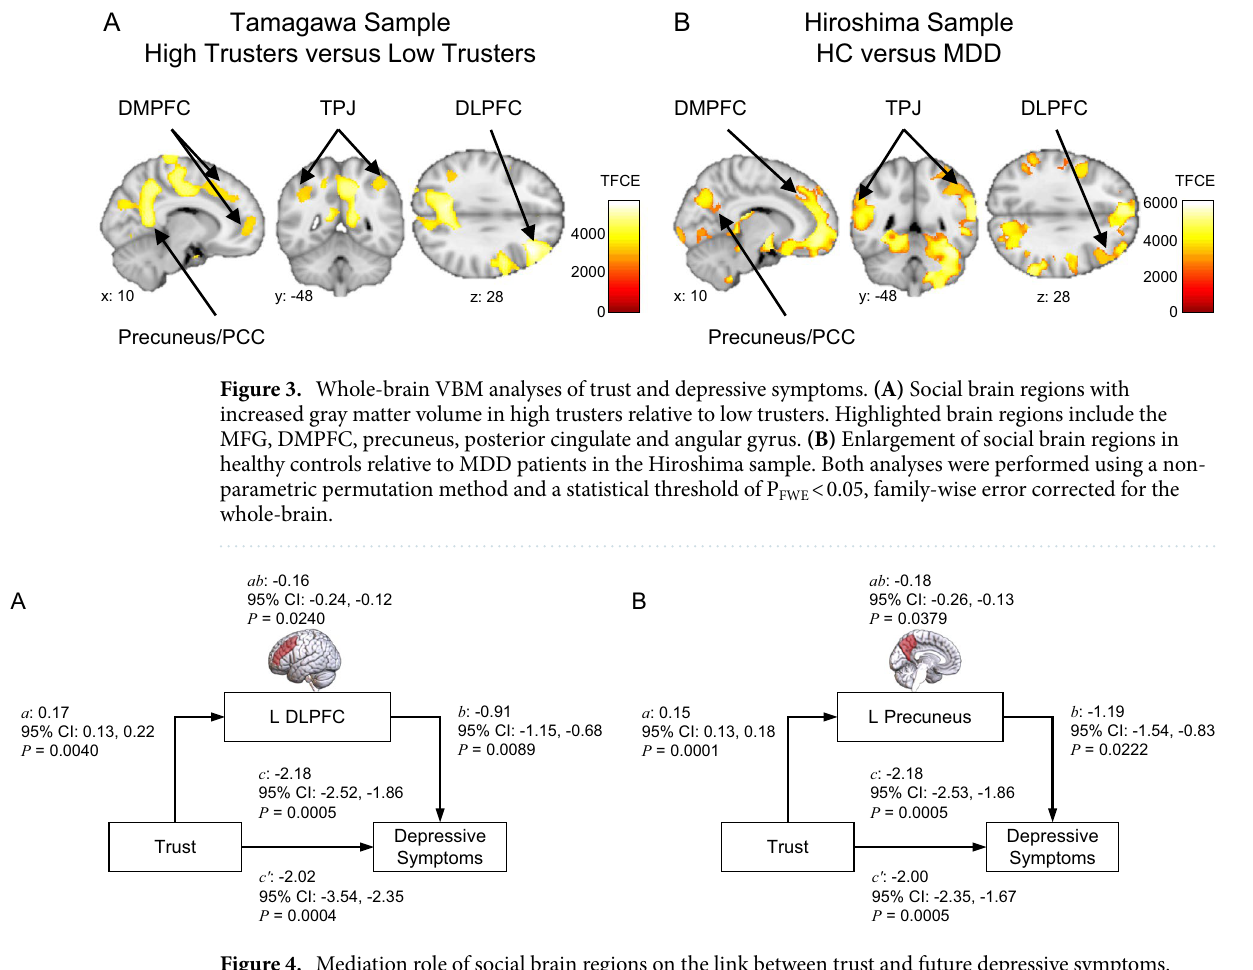
Figure 4. Mediation role of social brain regions on the link between trust and future depressive symptoms. Mediation analysis revealed significant indirect effects of GM volume of the left DLPFC (A) and left precuneus (B) on the relationship between trust and future depressive